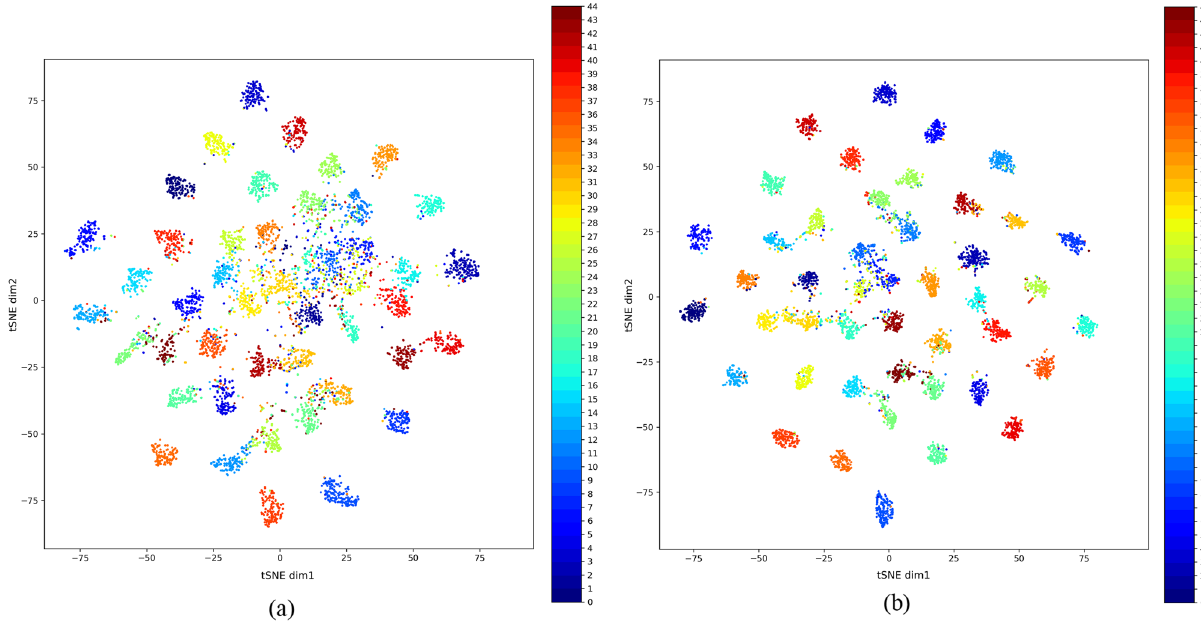
Figure 5. tSNE plots for the test set of the NWPU dataset. ( a ) plot after supervised training on the training set by fine-tuning the pre-trained efficientNet-B3 model, ( b ) plot after supervised training on the training set (downstream task) by fine-tuning the RS-FewShotSSL model pre-trained on the unlabeled set (pretext